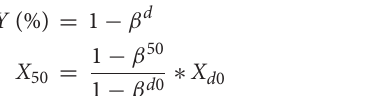
2017). Original SOC/TN stock data presenting stocks for a